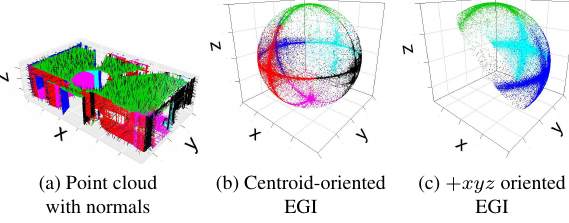
Figure 2. Extended Gaussian image of a cuboid shaped room